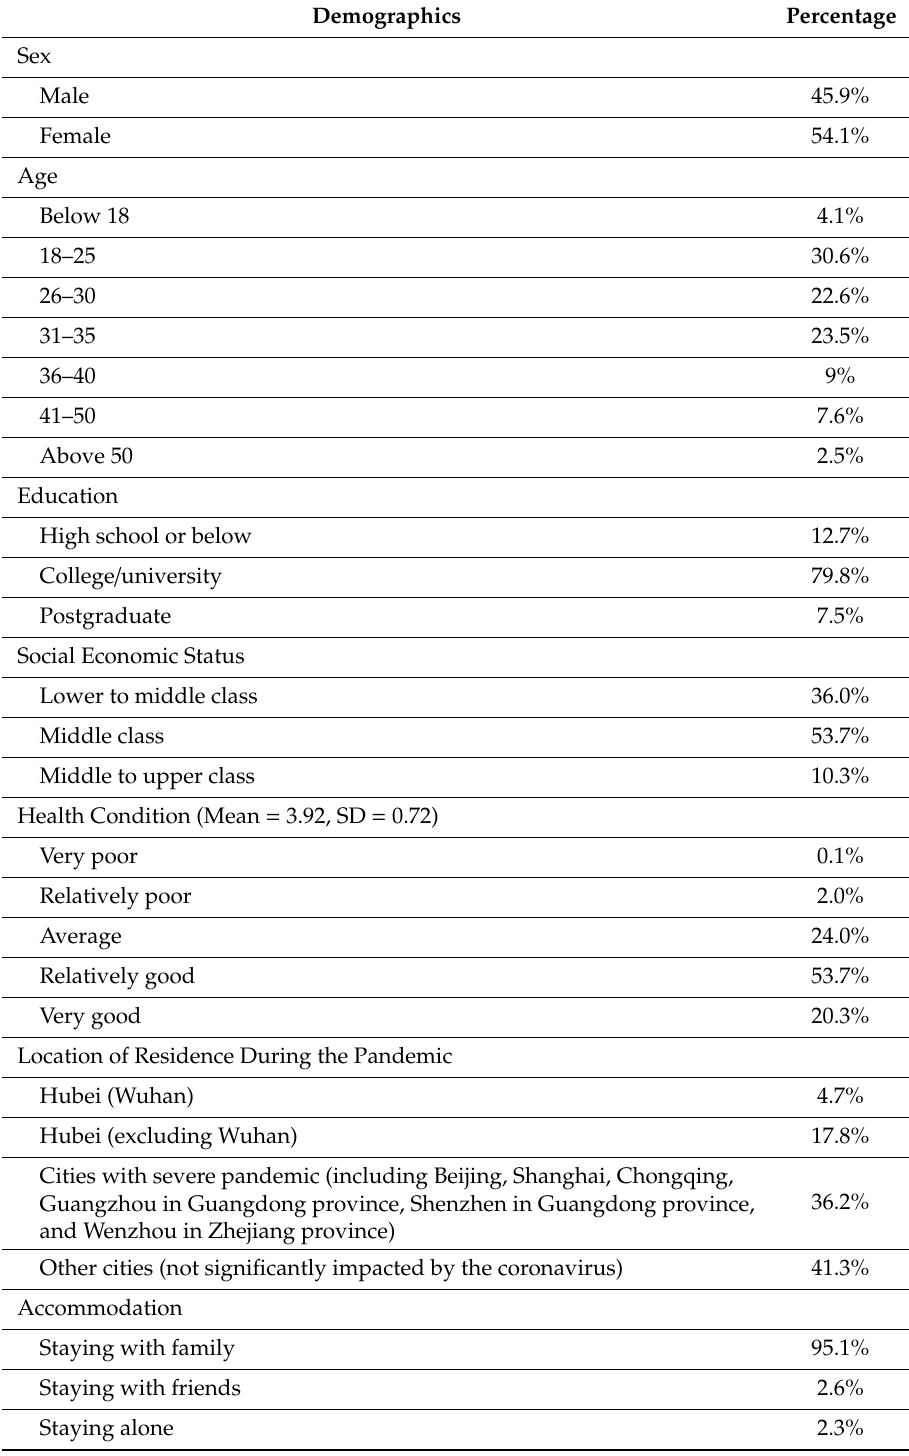
Table 1. Demographic